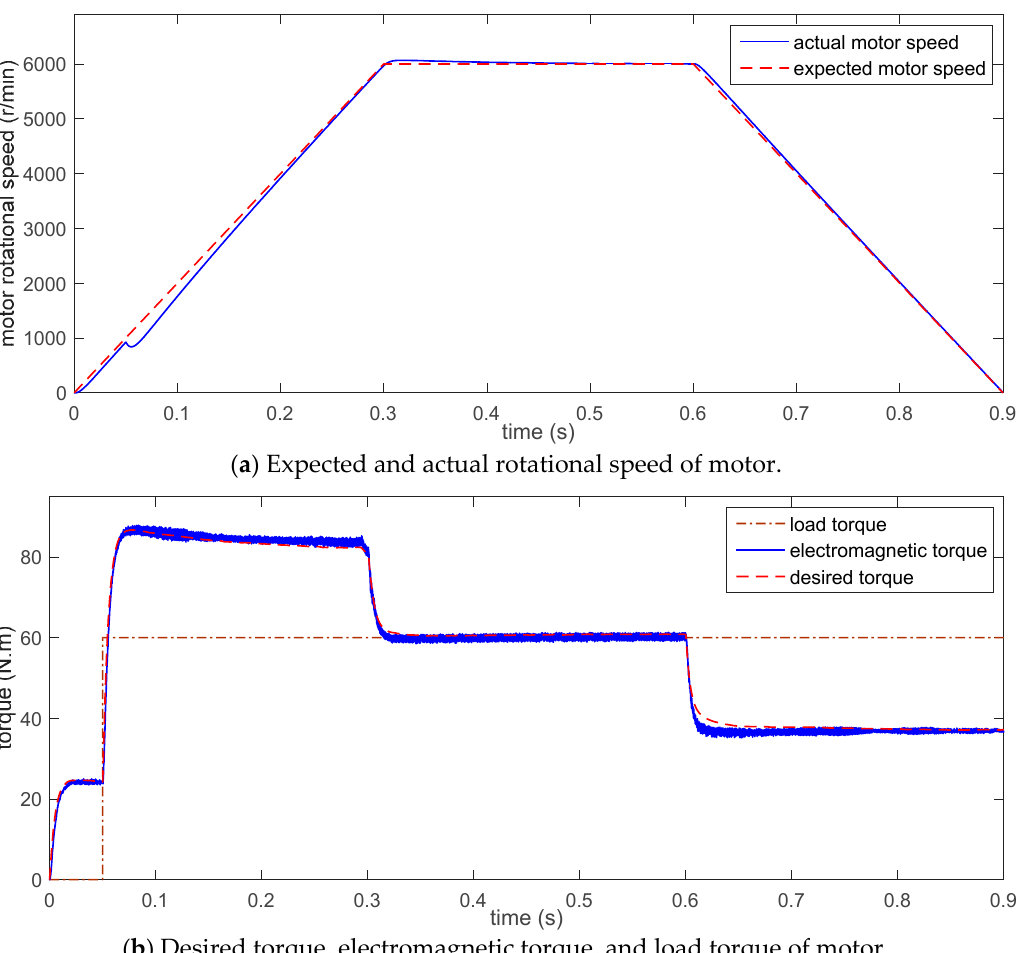
Figure 11. Curves of motor speed and torque.